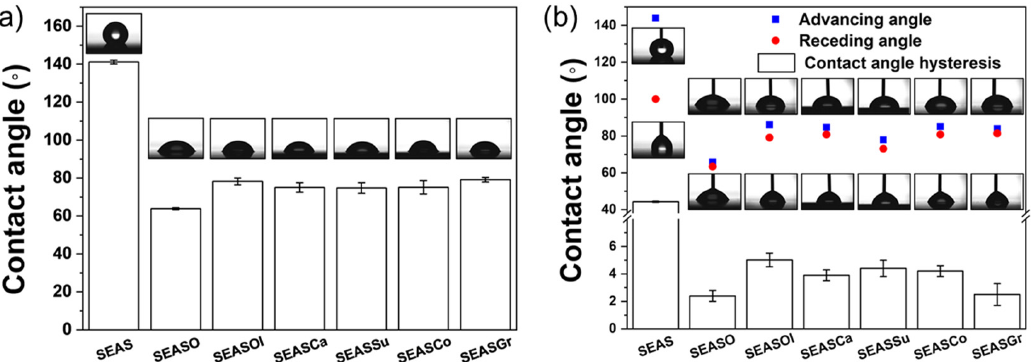
Figure 2. ( a ) Static contact angle and ( b ) advancing/receding contact angle, and contact angle hysteresis of water droplet.